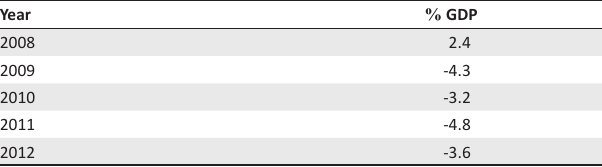
FIGURE 1: Southern African Development Community member states’ internal budgets, 2011–2015. TABLE 2: Southern African Development Community fiscal